Question: Give a one-sentence summary of this figure.
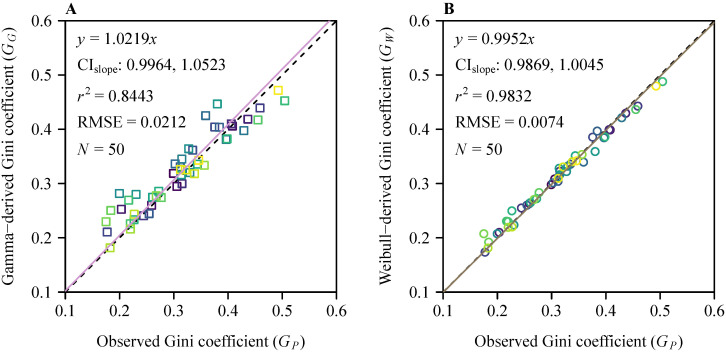
Answer: Linear fits to (A) the theoretical Gini coefficient of the Gamma distribution ( G G ) vs. the observed Gini coefficient calculated using the polygon method ( G P ), and (B) the theoretical Gini coefficient of the Weibull distribution ( G W ) vs. G P . For each panel, y represents G G in panel (A) or G W in panel (B) , and x represents G P ; CI slope represents the 95% confidence interval of the slope; r 2 is the coefficient of determination; RMSE is the root-mean-square error of the linear fit; N is the sample size, i.e., the number of species.